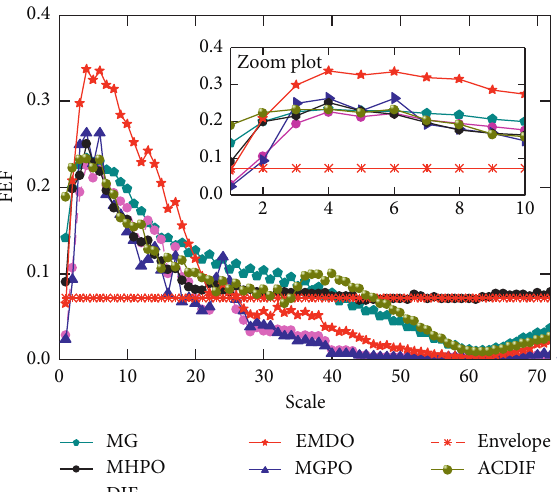
Figure 4: FEF factor of different operators with scale.